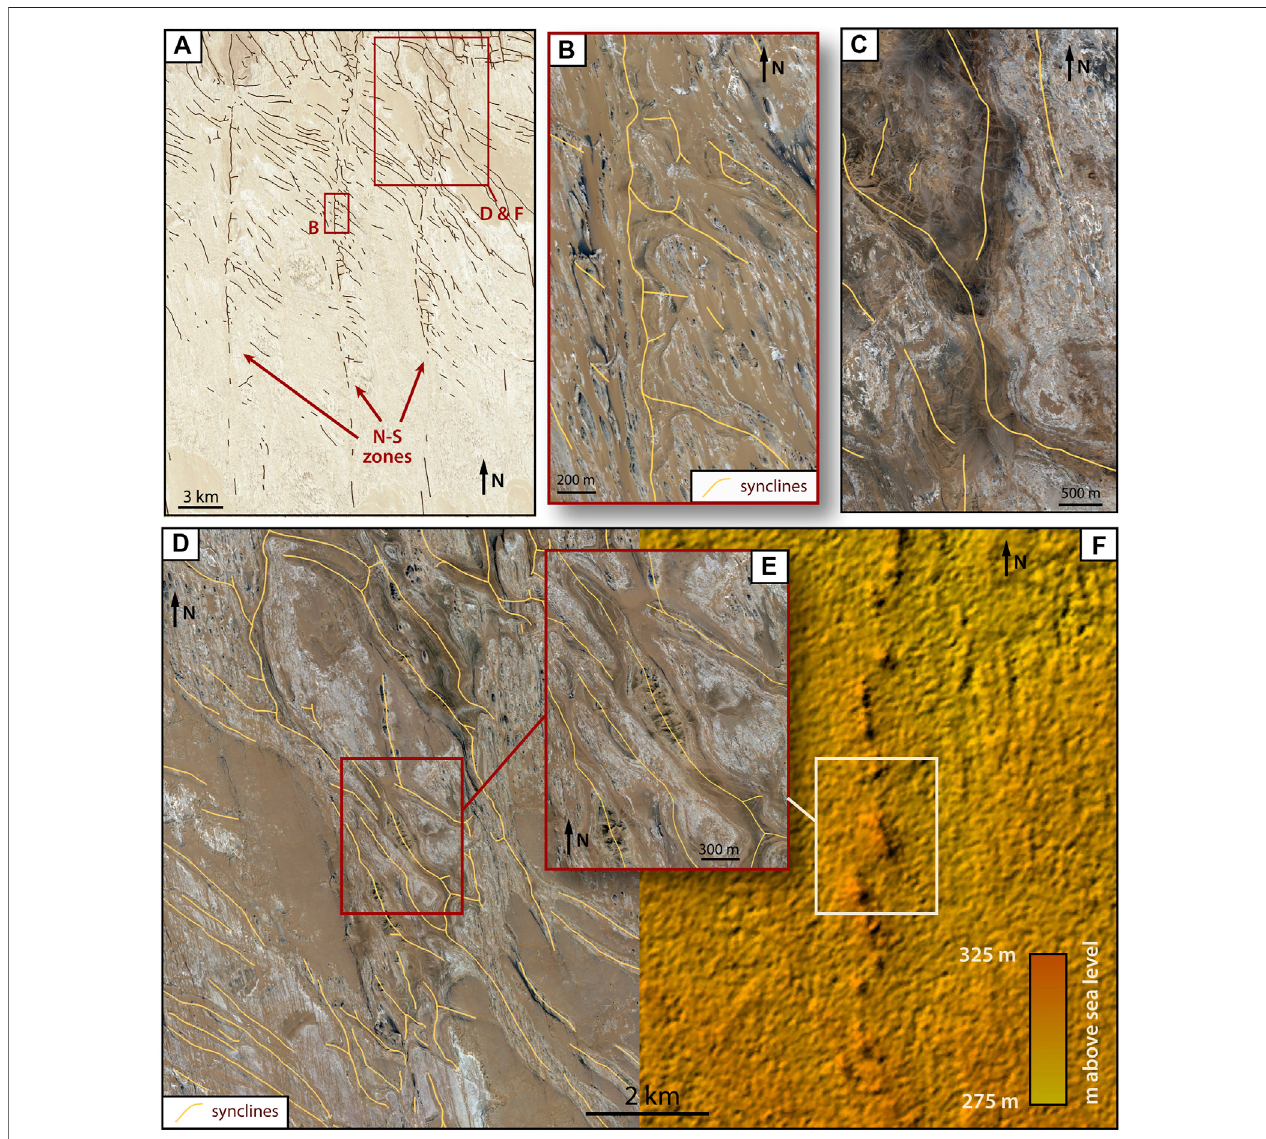
FIGURE12|(A) N – Szones1 – 3,mapareashownin Figure10 . (B) MergingofNW – SEtrendingsynclineswithN – Ssynclinesinzone2. (C) Synclinefromnorthern partofzone4AcomingintotheN – Szonefrompaneltotheeast,swingingN,continuingNNWandthenNWintothepanelwestofthezone. (D) Synclinesinzone3trend NNW-SSE across the zone. (E, F) Colorized shaded relief map (illumination direction from NW) covers samearea as (D) and shows en echelon ridges in the topography along zone 3. Synclines (E) coincide with the ridges. Satellite imagery source: Google Earth. Elevation model data source: Shuttle Radar Topography Mission (SRTM) digital elevation data.Coordinatesfor Google Earth images: A) 26.248415, 30.569295; B)26.246786,30.531585;C) 26.642740, 30.677912; D-F)26.307682, 30.595043.